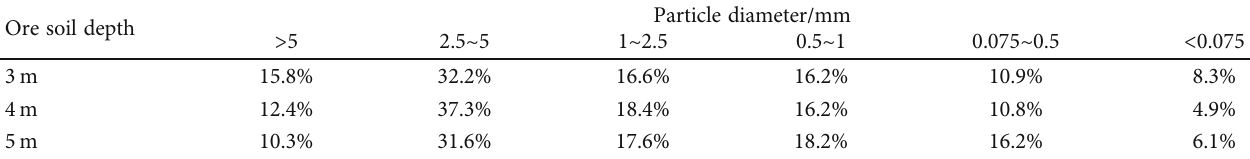
Table 2: Particle size percentage content of ore samples at di ff erent depths.